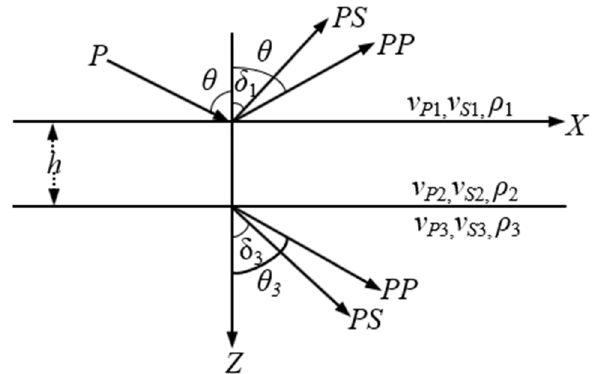
Figure 1. A thin-bed model with two horizontal interfaces. P is incident P-wave, PS is reflected or transmitted S-wave, PP is reflected or transmitted P-wave; h is thin-bed thickness; θ is incidence or reflected angle of P-wave, θ 3 is P-wave transmitted angle, δ 1 and δ 3 are S-wave reflected and transmitted angles respectively; v P and v S are P-wave and S-wave velocities respectively, ρ is density, and their subscripts 1, 2, 3 refer to three layers of the thin bed respectively.